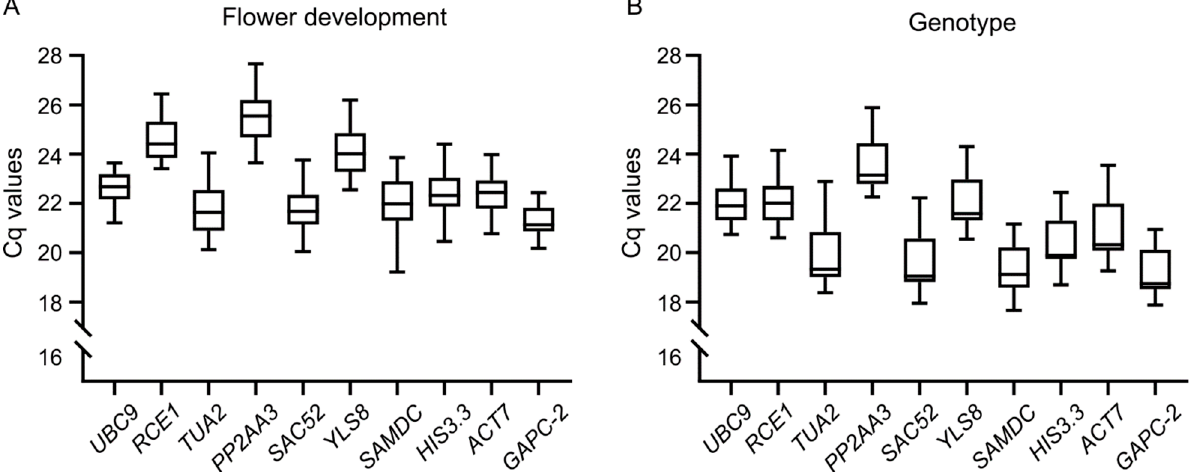
Figure 1. Distribution of Cq values obtained from the ten candidate reference genes. ( A ) Cq values of the ten candidate reference genes in the flower development group which included 21 samples corresponding to flower (st 1–16), silique (st 17), pistil (st 12), and anther (st 12) samples. ( B ) Cq values of ten candidate reference genes in the genotype set that comprised 12 samples corresponding to wt Col-0, jagger , wt No-0 and agp6 agp11 samples. The solid line within each box represents the median Cq values and the boxes denote the 1st and 3rd quartiles.